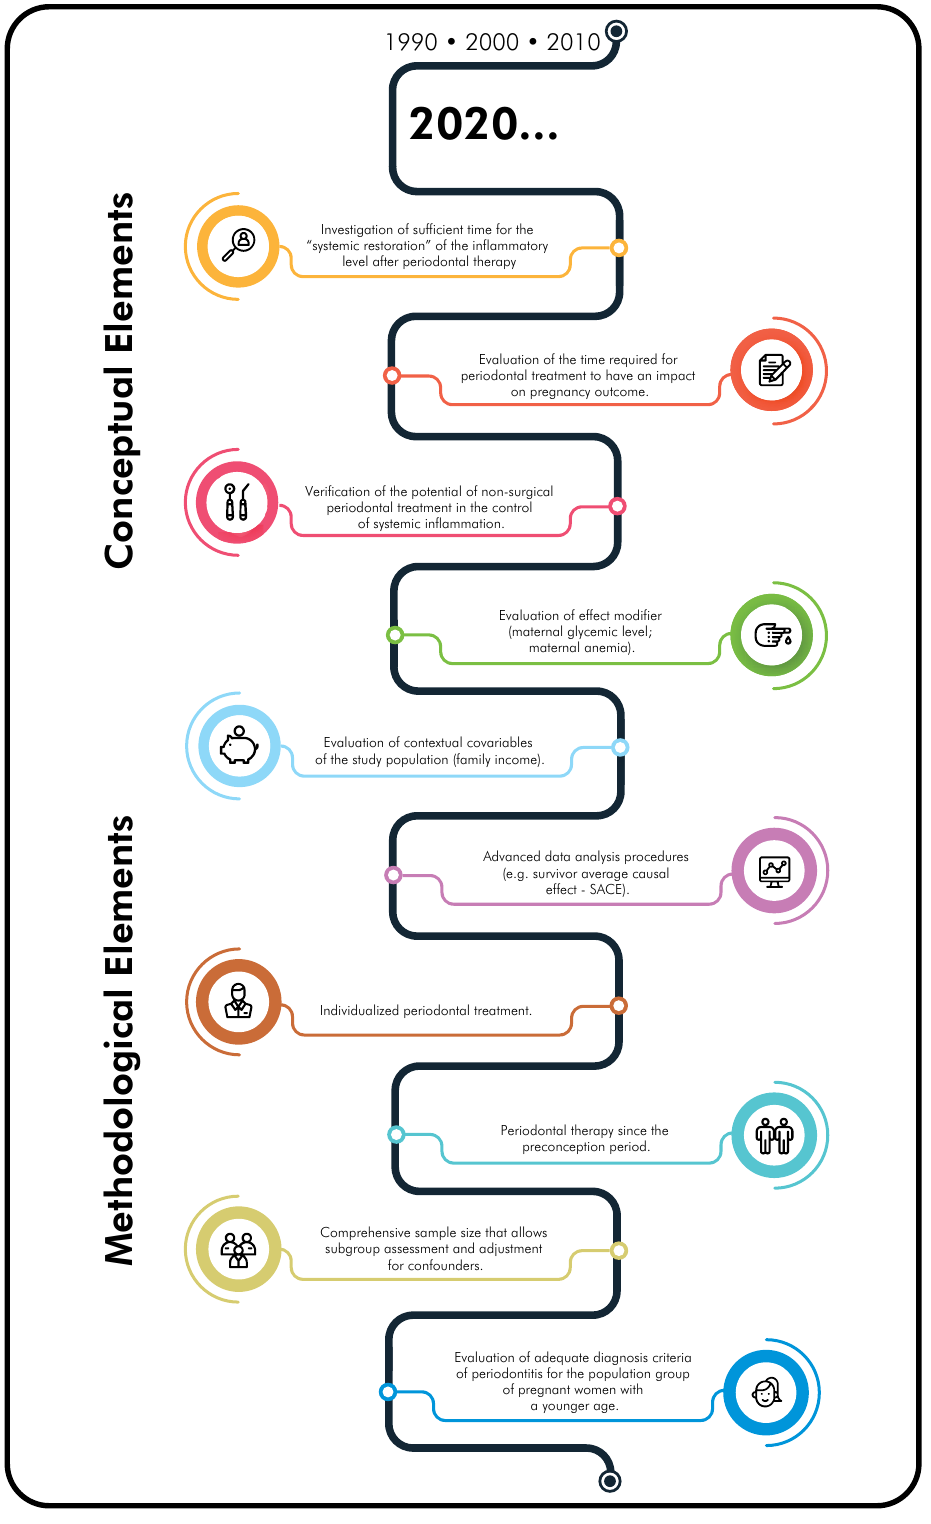
Figure. Possible future timeline for investigations into periodontitis and adverse pregnancy outcomes.